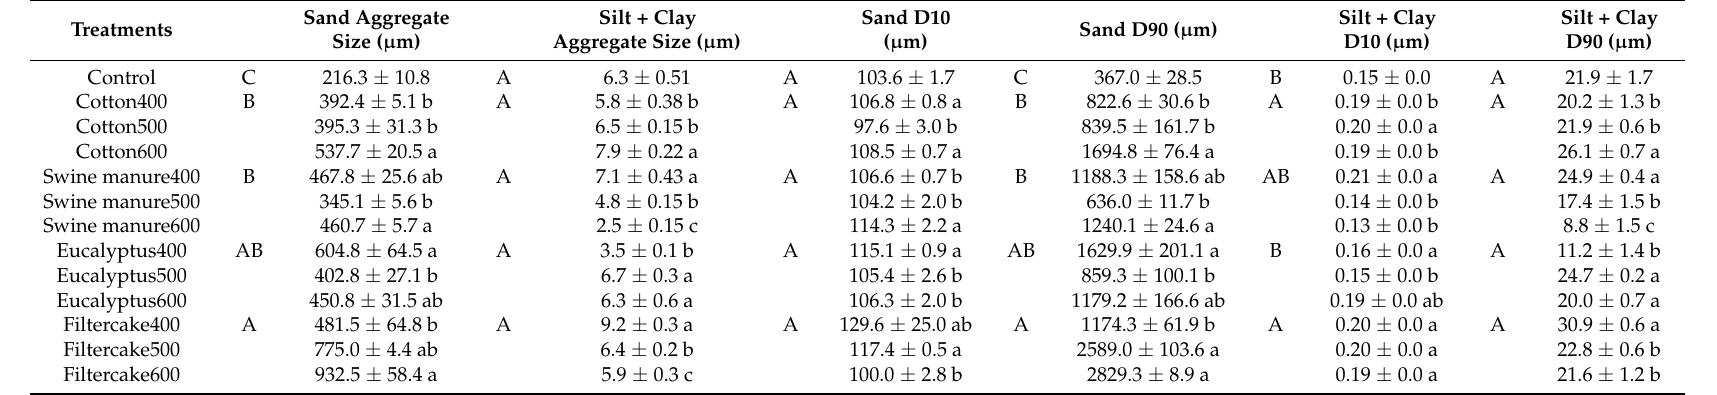
Table 5. Aggregate size and distribution of biochar-soil samples. Capital letters before values indicate significant differences between the feedstocks and lowercase letters indicate significant differences between the temperatures of pyrolysis for each feedstock ( n = 3; Tukey or Games-Howell tests, p < 0.05, where variances were